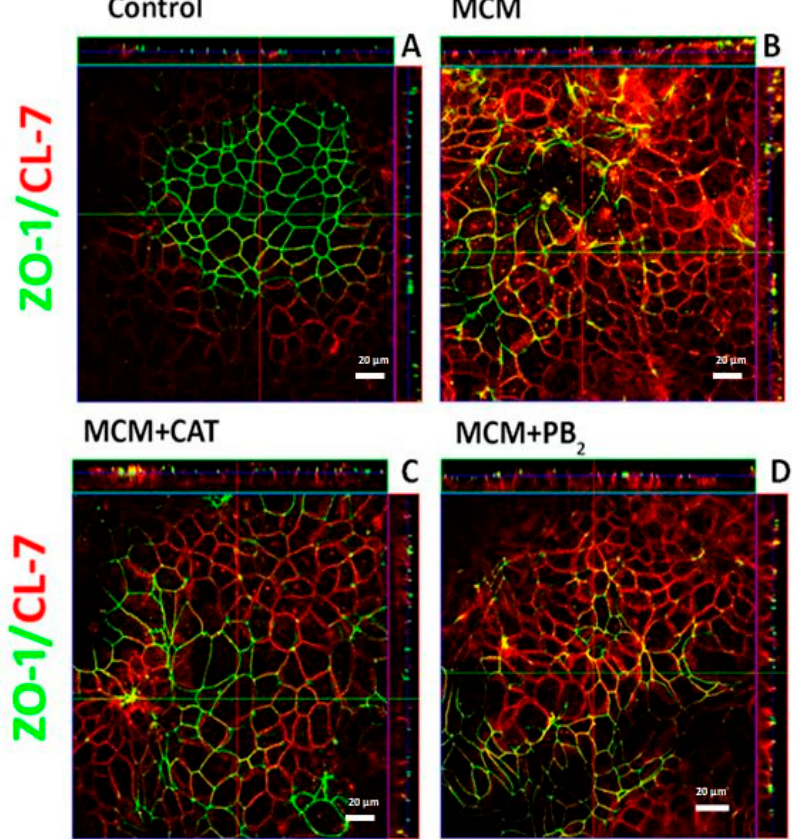
Figure 3. Distribution of ZO-1 and CL-7 in Caco-2 / HT29-MTX monolayers. Cell monolayers were incubated for 24 h in plain growth medium or with CAT or PB 2 (50 µ M), added at the apical side. The basolateral medium was then replaced with MCM or with the medium of Raw264.7 cultures not treated with LPS (control), and the incubation prolonged for further 72 h. At the end of the incubation, cell monolayers were fixed and immunostained for claudin-7 (red) and ZO-1 (green). For each condition, a single horizontal confocal section of a representative field is shown, with orthogonal projections. The experiment has been performed twice with similar results. Bar = 20 µ